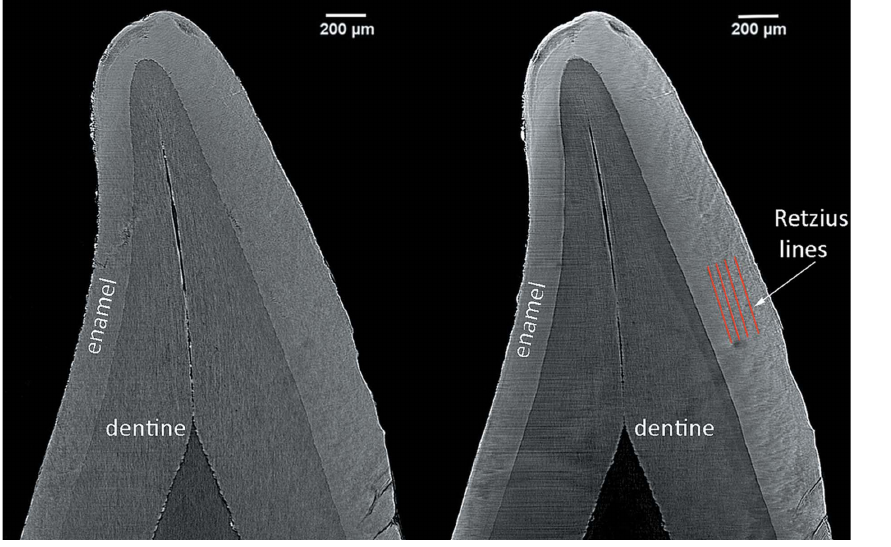
Figure 2 Velia 387 lower deciduous central incisor. Vestibular-lingual reformatted images from SR m CT, isotropic voxel size = 2.0 m m. Different slice thicknesses (left 2.0 m m, right 40 m m) of the same volume highlight different features. Horizontal lines visible in the images correspond to the plane of the tomographic slices.